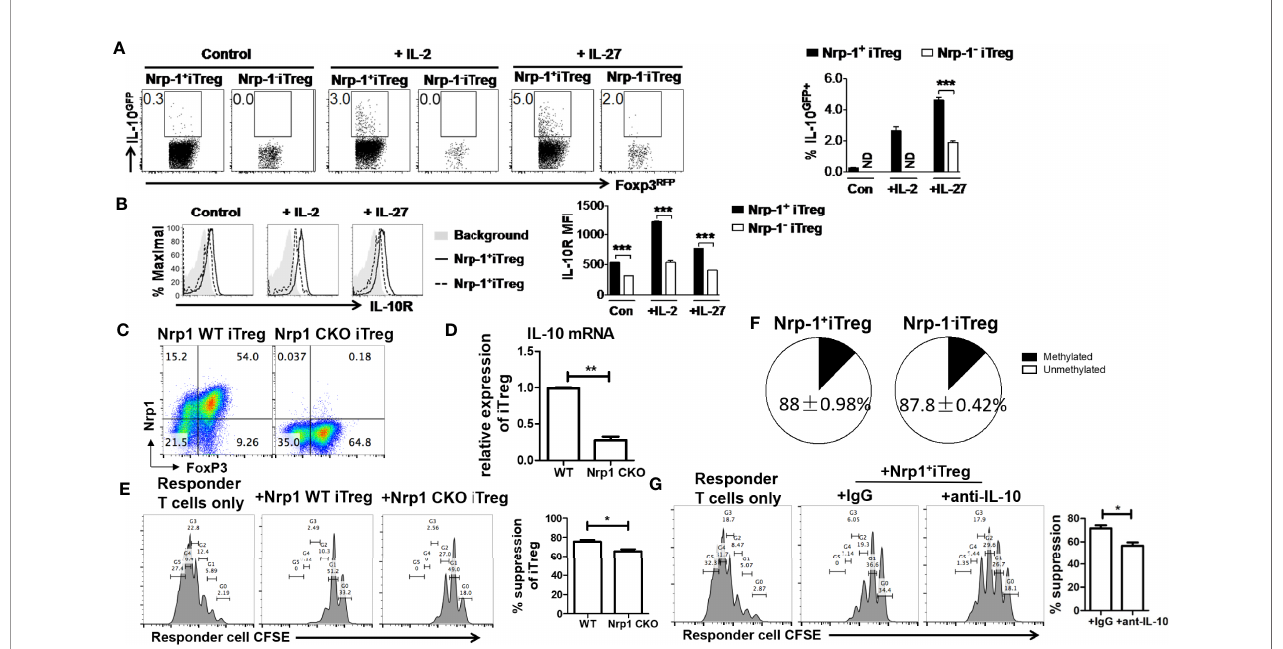
FIGURE 5 | IL-10 may be account for a superior functional activity of Nrp-1 + iTreg in vitro . (A, B) After resting for 4 days, Nrp-1 + iTreg and Nrp-1 - iTreg were restimulated with mitomycin-C treated APC (Rag-/-) in the presence of 1 ug/ml anti-CD3/28. Cells were analyzed ~50 hours post restimulation. Control: no supplemental cytokines; +IL-2: + 40U/ml rh-IL-2; +IL-27: + 20ng/ml rm-IL-27. Cells were analyzed ~ 50 hours post restimulation. IL-10 and IL-10R were measured in Nrp-1 + iTreg and Nrp-1 - iTreg. (C – E) CD4 cre /Nrp1 fl ox/ fl ox mice were generated to conditional knockout Nrp-1 (Nrp-1 CKO) in CD4 + T cells. CD4 cre mice were set as wild-type (WT) control. Nrp-1 CKO iTreg and WT iTreg were generated from naïve CD4 + T cells in Nrp-1 CKO and Nrp-1 WT mice respectively. Foxp3 expression was equivalent in Nrp-1 CKO iTreg and WT iTreg. IL-10 mRNA expression was much higher in WT iTreg than that in Nrp-1 CKO iTreg (n=5). There was an inferior functional activity of Nrp-1 CKO iTreg in suppressing CD8 + T cells (Ratio 1/1) in vitro (n=5) by an analysis of fl ow-based suppression assay. Representative plots and the summarized data of different experiments were shown. The data indicate the Mean ± SEM of 3 separated experiments (* p <0.05, ** p <0.01, *** p <0.001). (F) The methylation levels were detected by primers designed for the TSDR region in Nrp-1 + iTreg (n=4) and Nrp-1 - iTreg (n=4). Nrp-1 + iTreg and Nrp-1 - iTreg had similar DNA methylation. (G) Anti-IL-10 antibody or IgG were added in the suppression system of Nrp-1 + iTreg against CD8 + T cells (Ratio 1/1) in vitro (n=4) by an analysis of fl ow- based suppression assay (* p